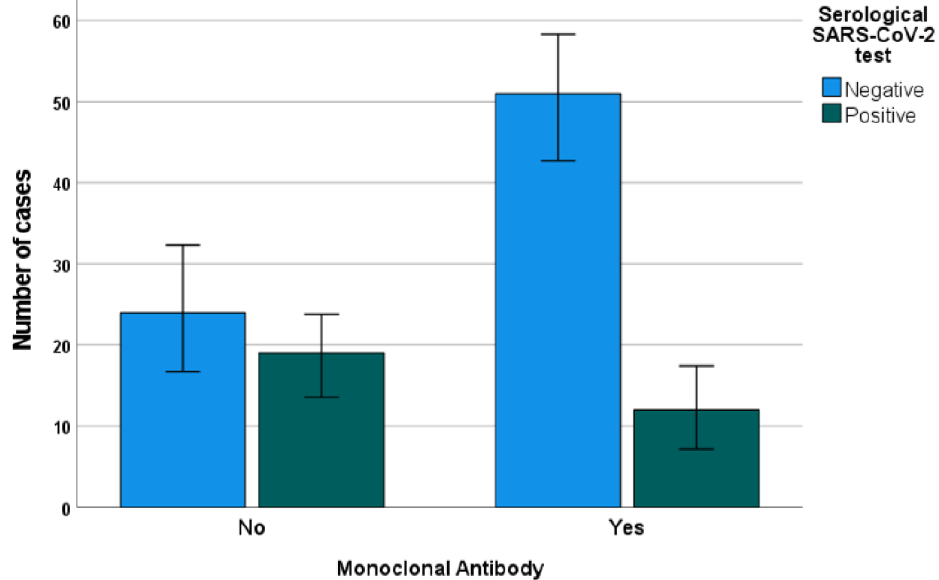
Figure 1. Frequency of serological positivity for SARS-CoV-2 antibodies among IBD patients receiving or not receiving therapy with monoclonal antibodies. Whiskers represent 95% error bars.